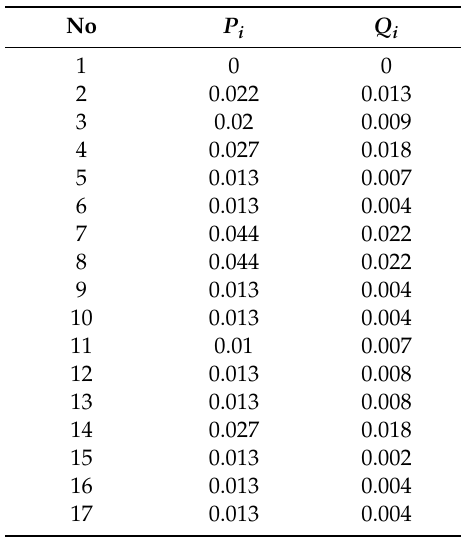
Table A1. Bus data of 33-bus test network